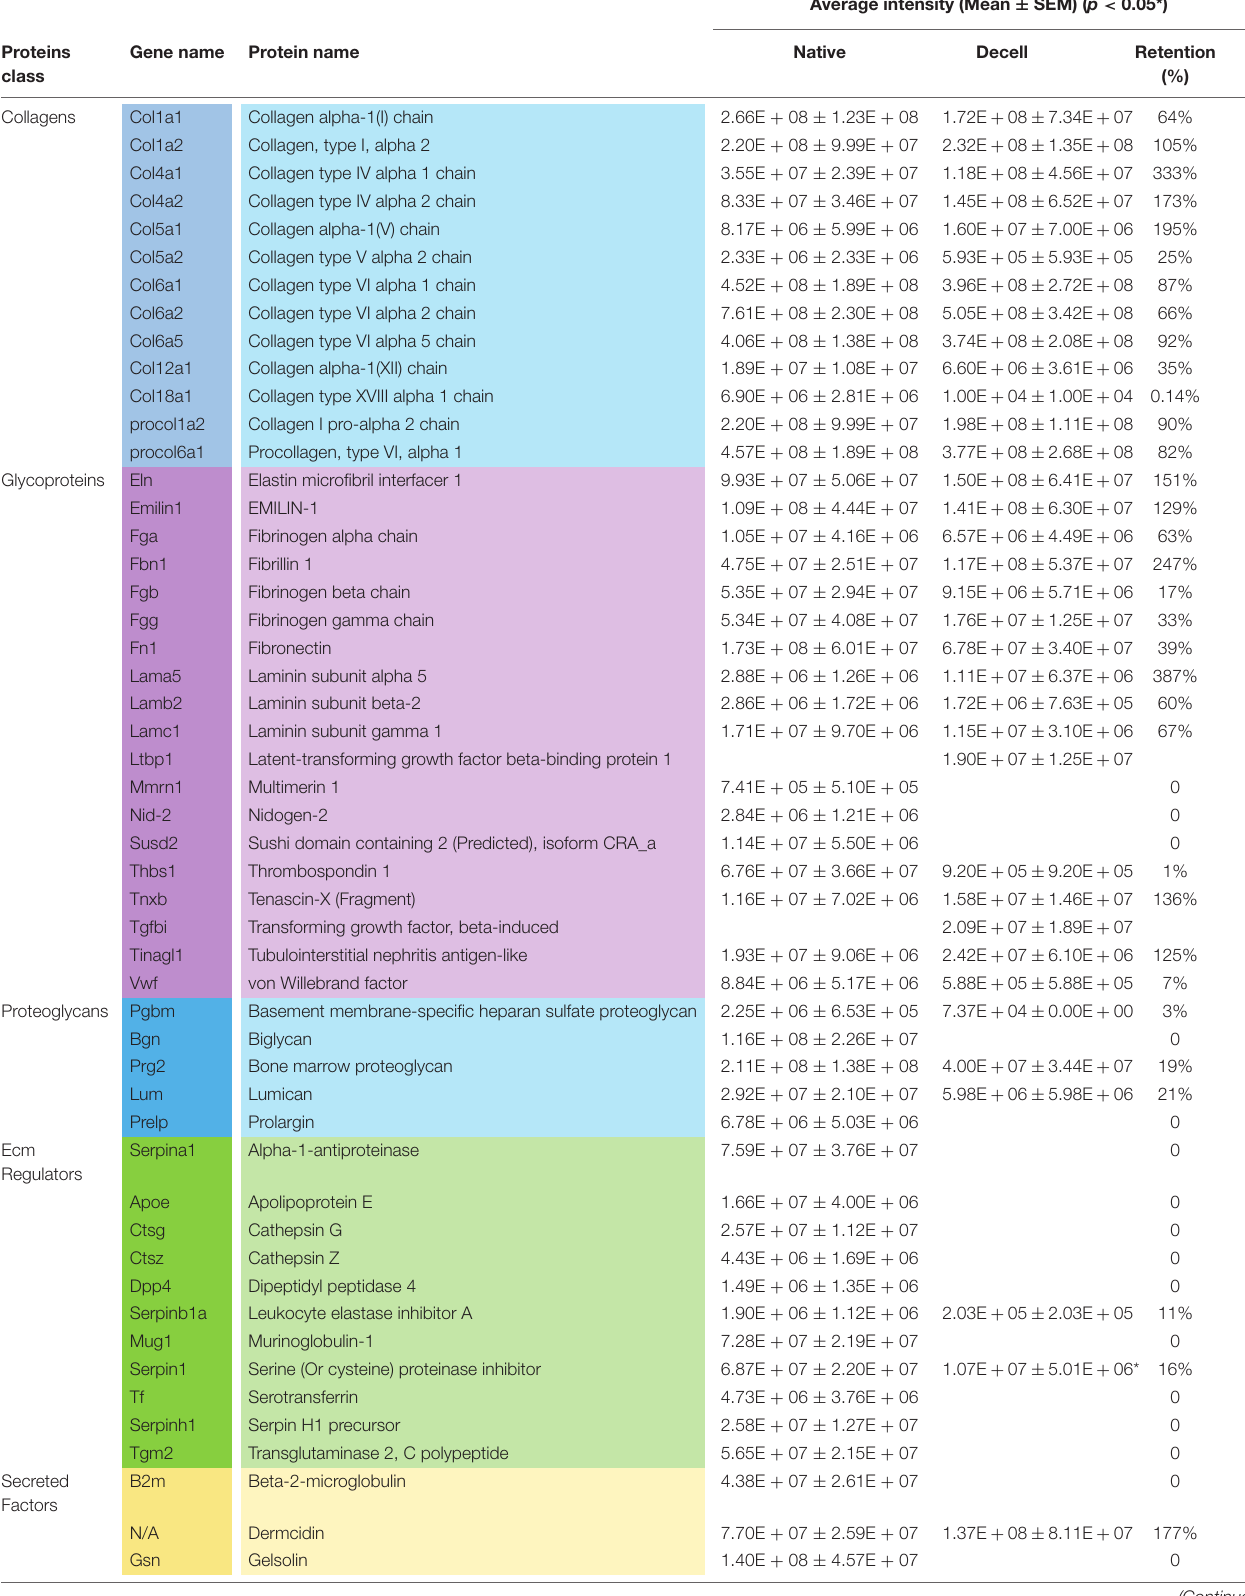
Average intensity (Mean ± SEM) ( p <